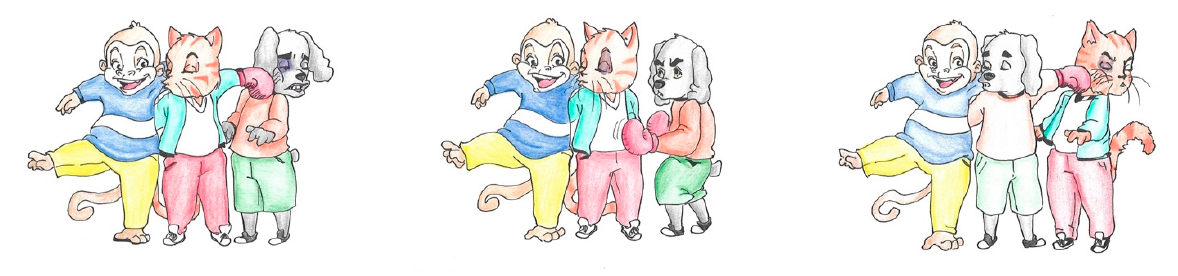
Figure A17. ORC stimulus 2.